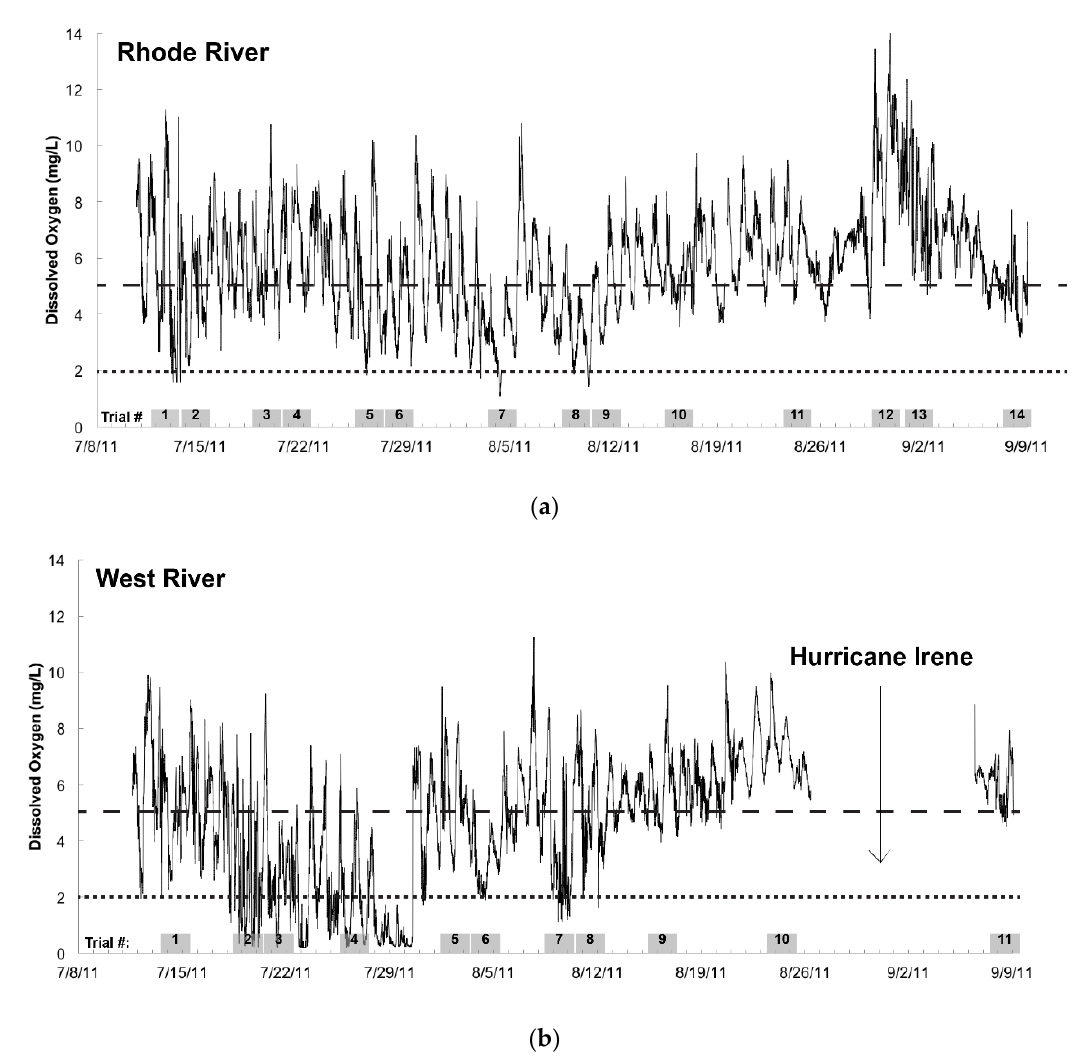
Figure 2 . ( a ) Dissolved oxygen during the study period in the Rhode River; ( b ) Dissolved oxygen during the study period in the West River. The timing of field trials is indicated by gray bars along the time axis. The dashed and dotted lines indicate dissolved oxygen thresholds of 5 mg/L and 2 mg/L, respectively. The water quality sonde was removed from the West River during Hurricane Irene. Table 1. Summary of multiple linear regression models of predation mortality, testing for the effect of bivalve species, species × site, duration of moderate hypoxia, and duration of severe hypoxia during, before, and before plus during, predation trials. Significant p -values are in bold.